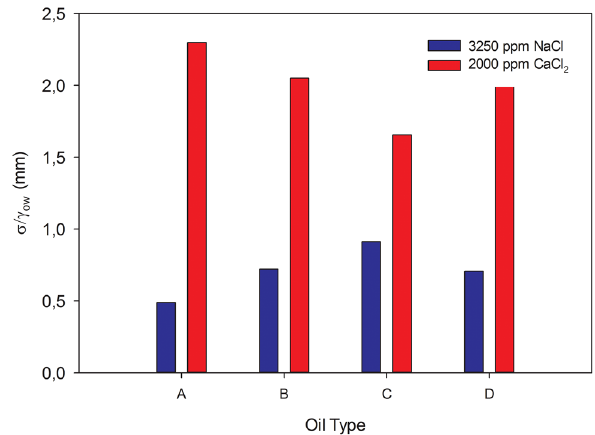
Fig. 4 Line tension to IFT ratios for four crude oils and low salinity brine systems with Na + and Ca